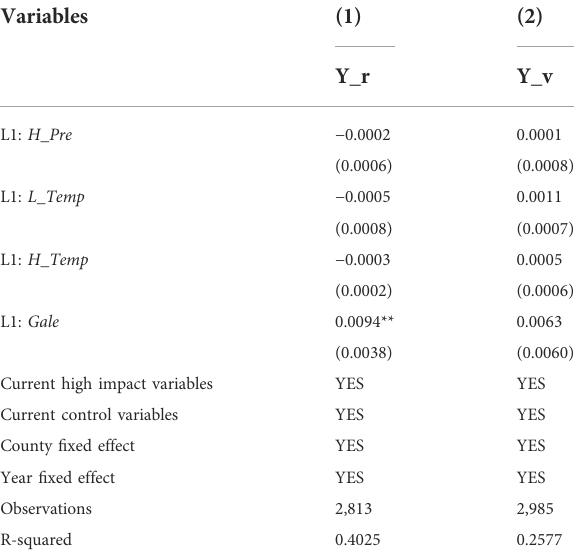
TABLE 4 Robustness test 2: Lag